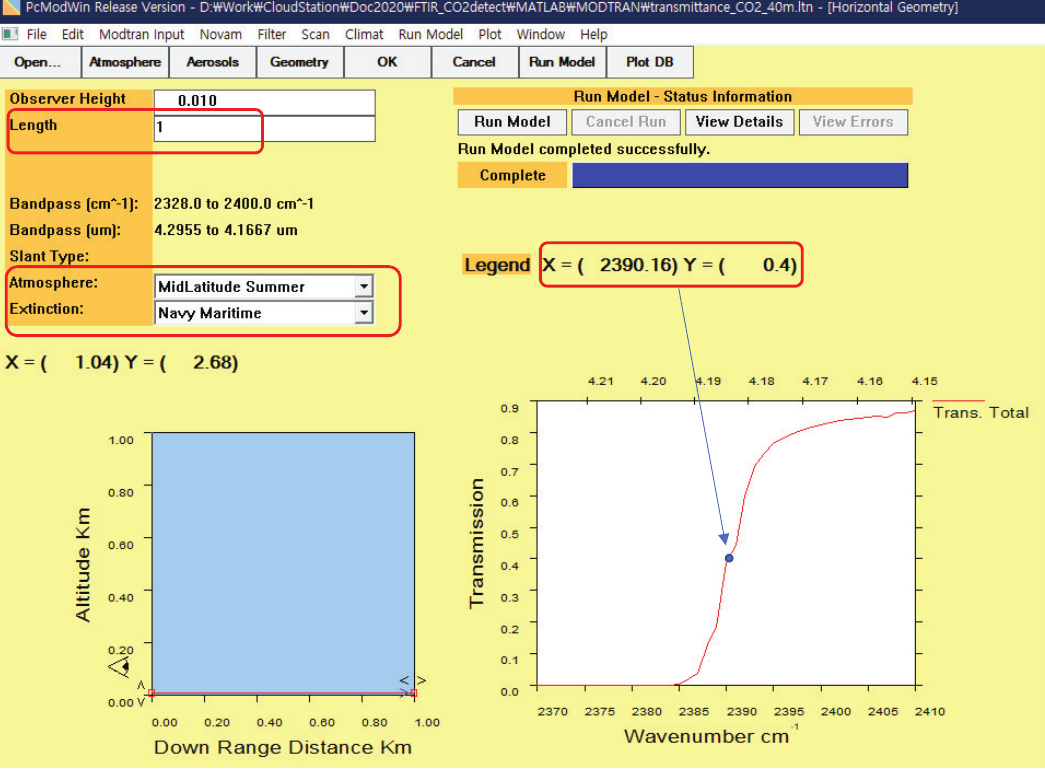
Figure 18. Moderate-Resolution Atmospheric Radiance and Transmittance (MODTRAN) environment for atmospheric transmittance